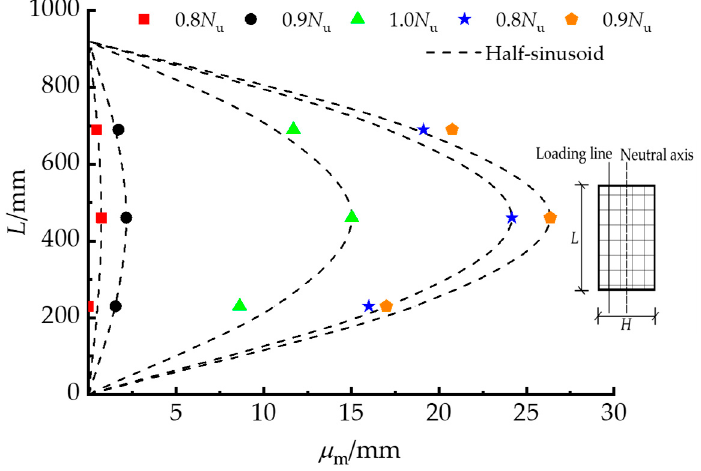
Figure 6. Lateral deflection curve of the typical specimen.